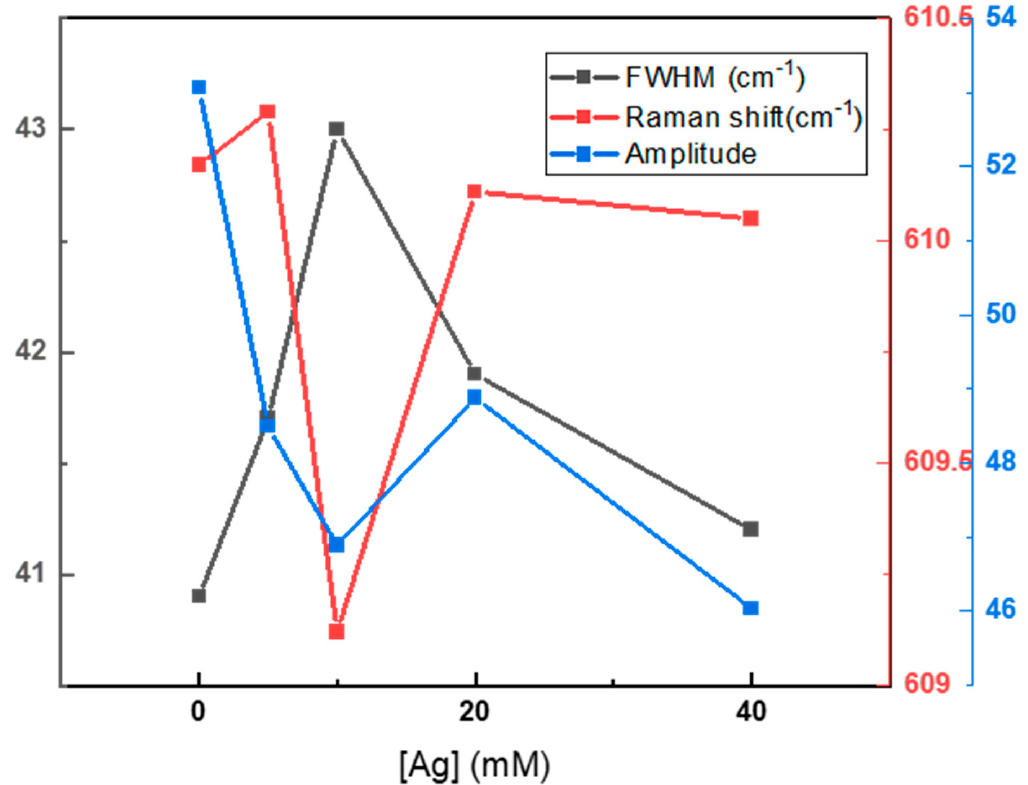
Figure 4. Extracted parameters (Raman peak position, FWHM, amplitude) from the fitting of the phonon mode located at 611 cm − 1 by using Lorentzian function, adj. R-squared 0.996.